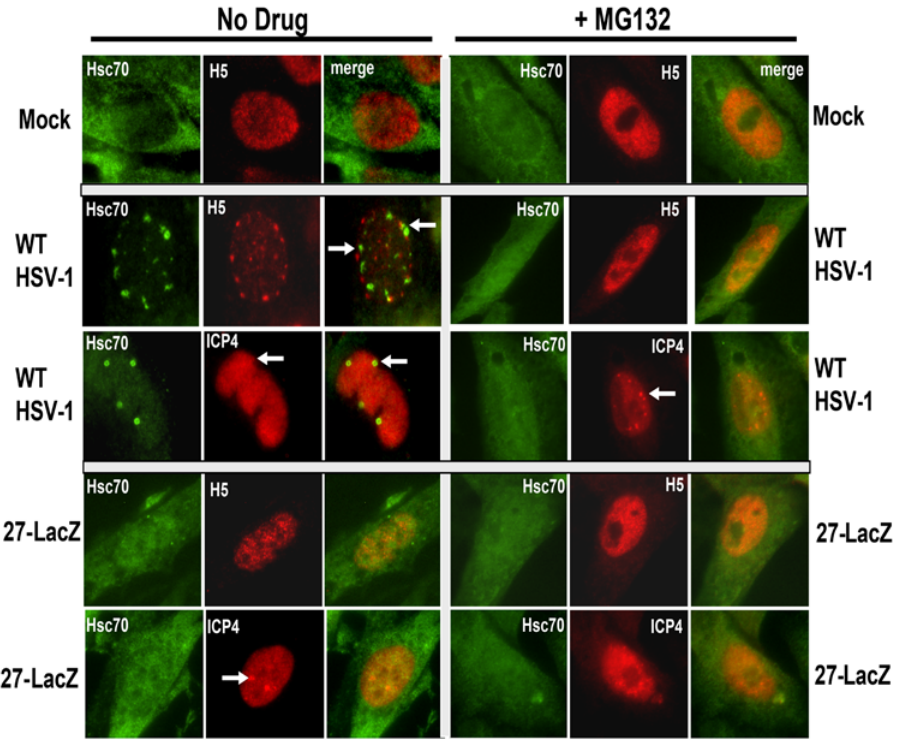
Figure 8. Preventing Phospho-serine 2 RNAP II Degradation Also Prevents Hsc70 Focus Formation. Vero cells that were mock-infected or were infected with WT HSV-1 or 27-LacZ were untreated (left panels) or were treated with 50 m M MG132 added 1 h after infection (right panels). Cells were fixed at 8 h after infection and stained with anti-Hsc70 antibody, antibody H5 and anti-ICP4 antibody as indicated. Arrows mark Hsc70 foci (green) or replication or pre-replication sites